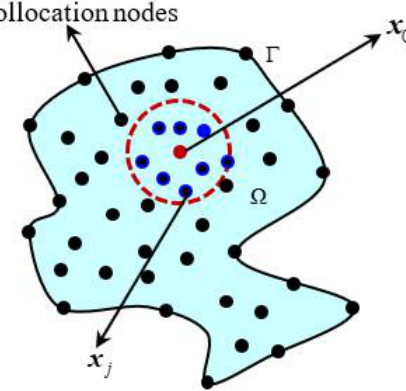
x . Figure 1. A star of collocation node x 0 0